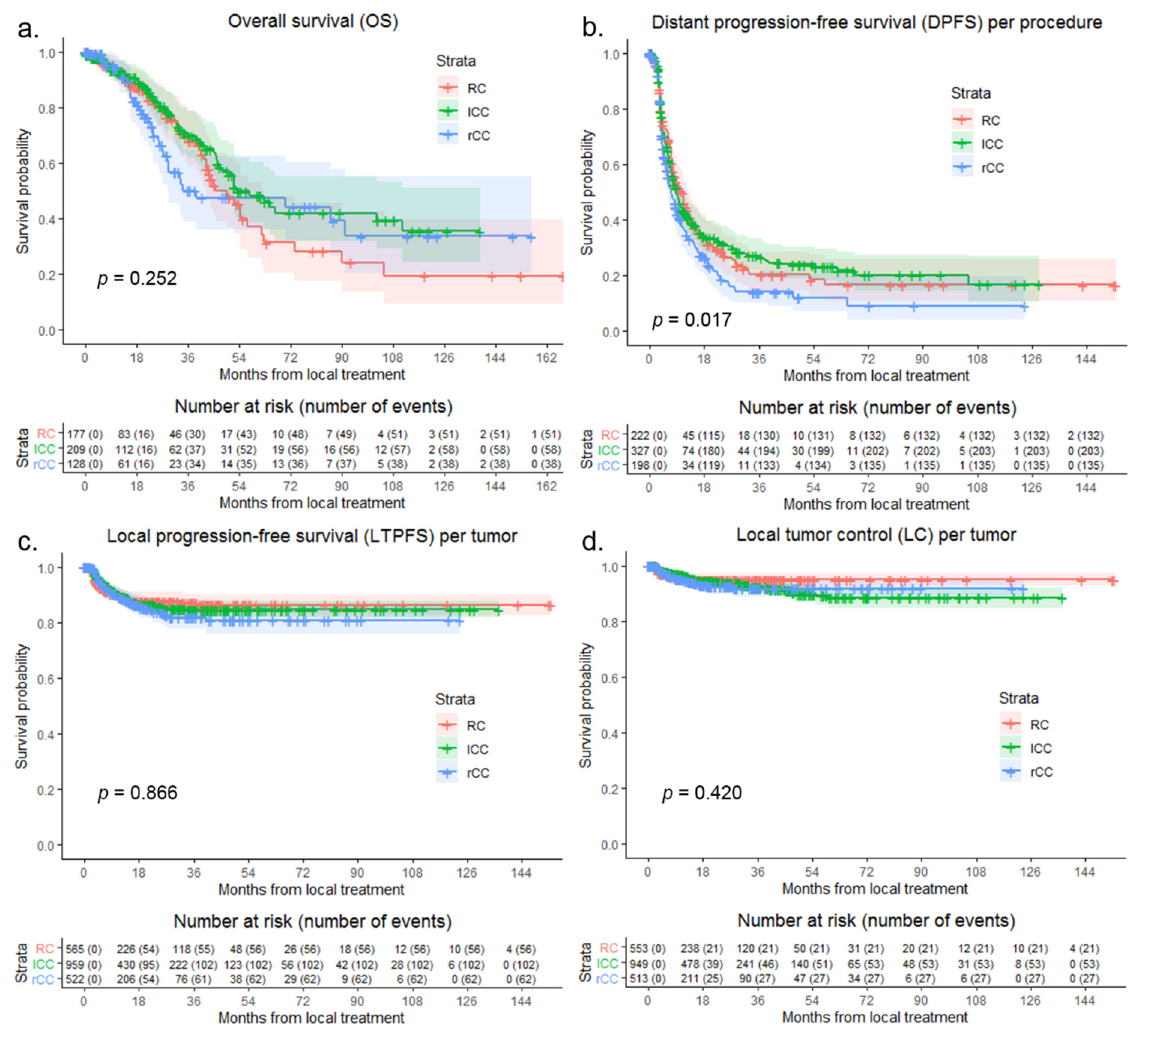
Figure 2. Kaplan–Meier curves, with log-rank (Mantel–Cox) test or Gehan–Breslow–Wilcoxon test, of ( a ) overall survival (OS) per patient ( p = 0.252), ( b ) distant progression-free survival (DPFS) per procedure ( p = 0.017), ( c ) local tumor progression-free survival (LTPFS) per tumor ( p = 0.866), and ( d ) of local control (LC) per tumor ( p = 0.420) after local treatment comparing RC (pink), left-sided CC (green) and right-sided CC (blue). Numbers at risk (number of events) are per patient, per procedure and per tumor. Death without distant progression, local tumor progression (LTP) or loss of LC (competing risk) is censored.